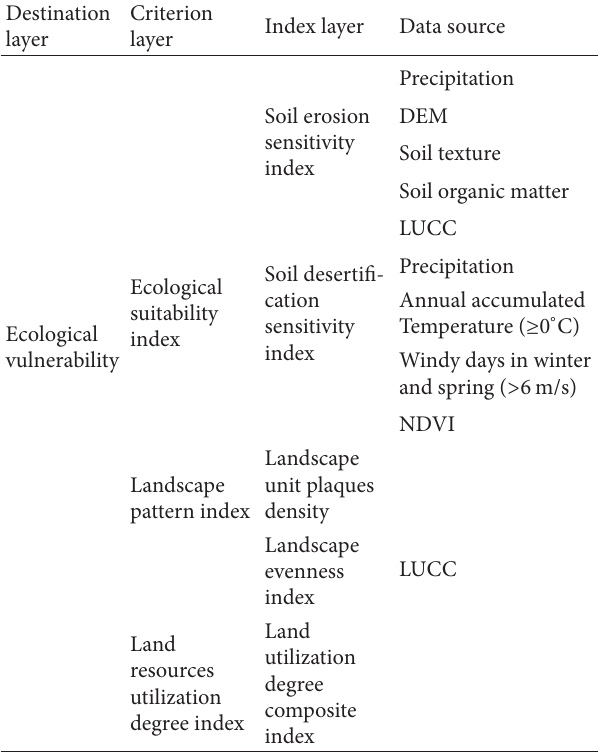
Table1:Theecologicalvulnerabilityindexsystemofthewood-grass ecotone of Northeast